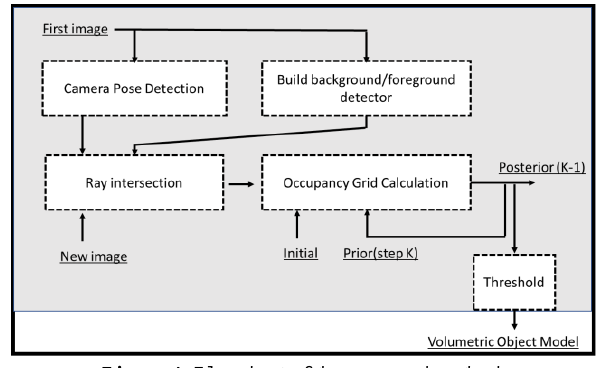
Figure 4. Flowchart of the proposed